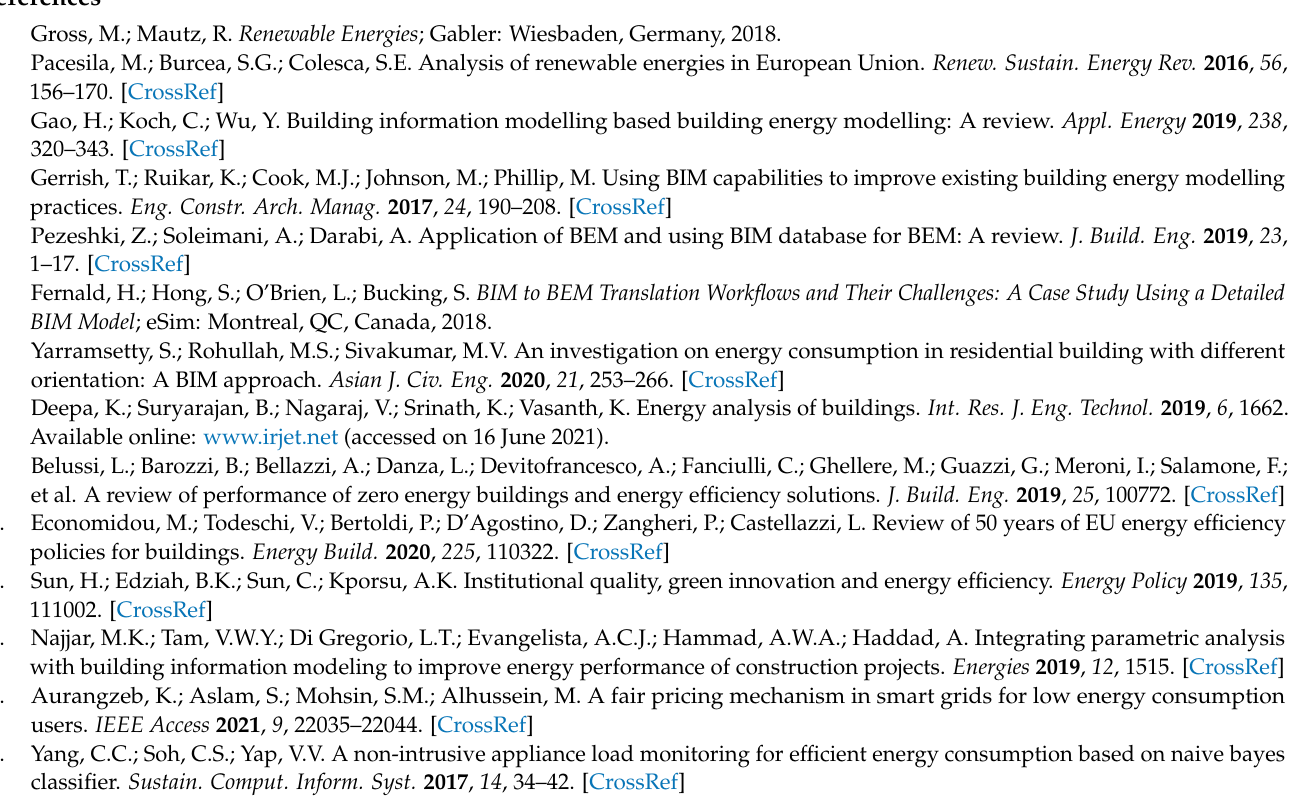
for Armaç ã o dos B ú zios; Table S6: Factor Information for Capri; Table S7: Analysis of Variance for Capri; Table S8: Model Summary for Capri; Table S9: Coefficients for Capri; Table S10: Regression Equation for Capri; Table S11: Factor Information for Punta Cana; Table S12: Analysis of Variance for Punta Cana; Table S13: Model Summary for Punta Cana; Table S14: Coefficients for Punta Cana; Table S15: Regression Equation for Punta Cana; Table S16: Factor Information for Dubai; Table S17: Analysis of Variance for Dubai; Table S18: Model Summary for Dubai; Table S19: Coefficients for Dubai; Table S20: Regression Equation for Dubai; Table S21: Factor Information for Sydney; Table S22: Analysis of Variance for Sydney; Table S23: Model Summary for Sydney; Table S24: Coefficients for Sydney; Table S25: Regression Equation for